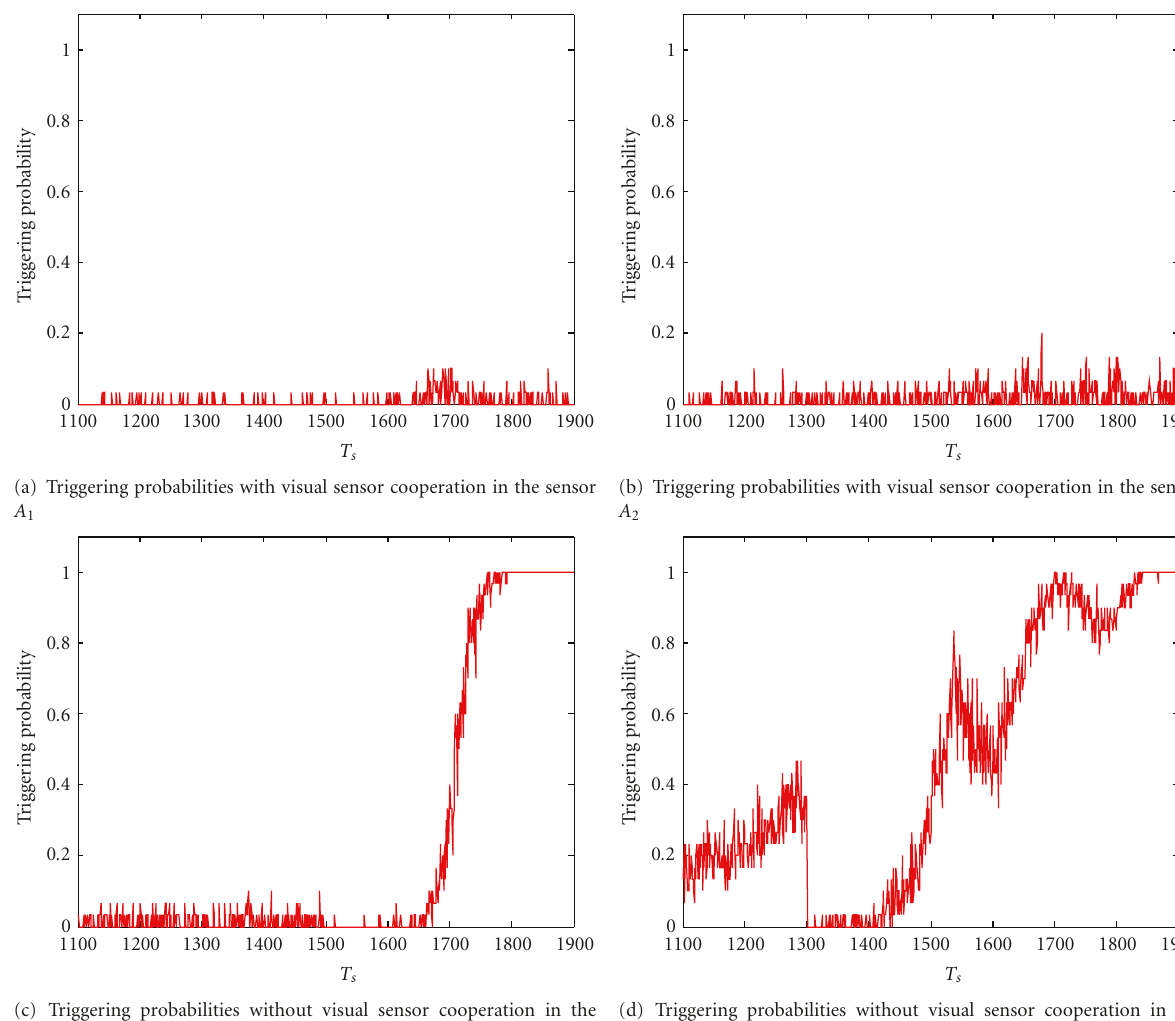
(d) Triggering probabilities without visual sensor cooperation in the sensor A 2 Figure 21: Triggering probabilities of two sensors between 1101 T s and 1900 T s